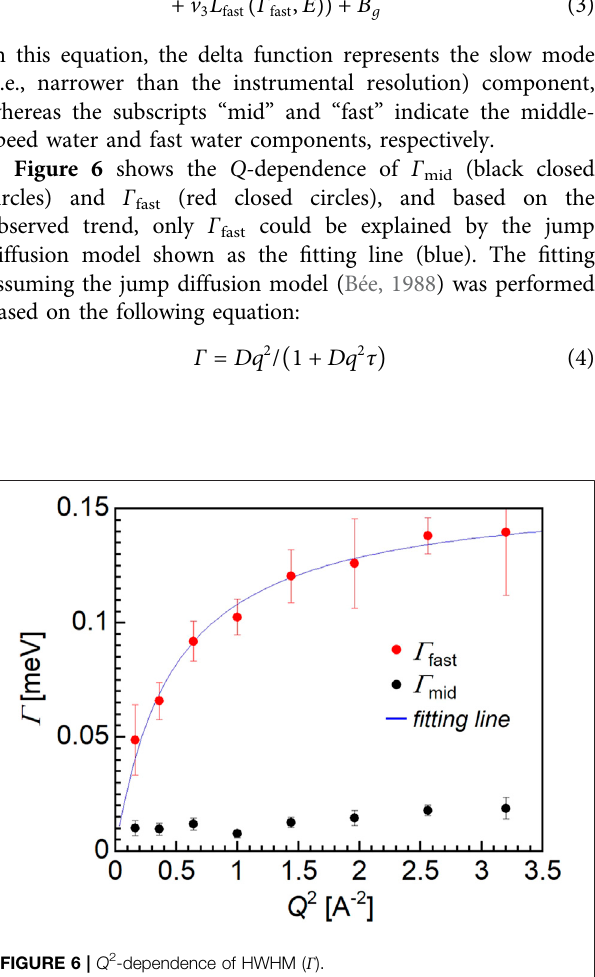
FIGURE 6 | Q 2 -dependence of HWHM ( Γ